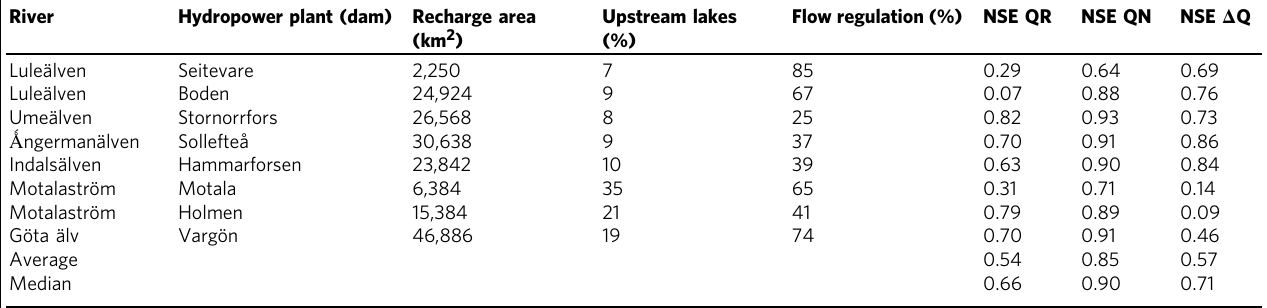
Table 1 Model skills in predicting hydropower regulation